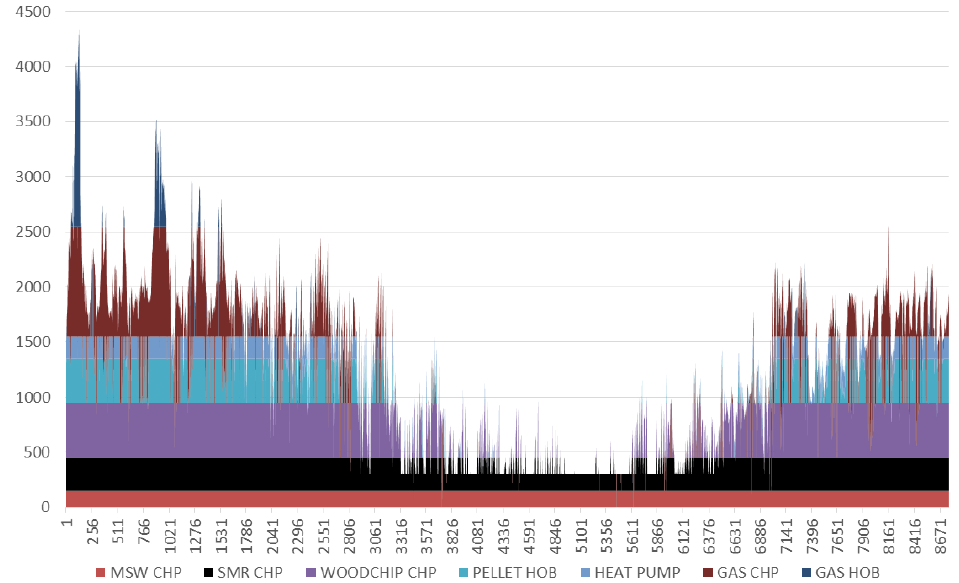
Figure 6. The modelled district heat production distribution with small modular reactor (SMR) CHP in 2030 in